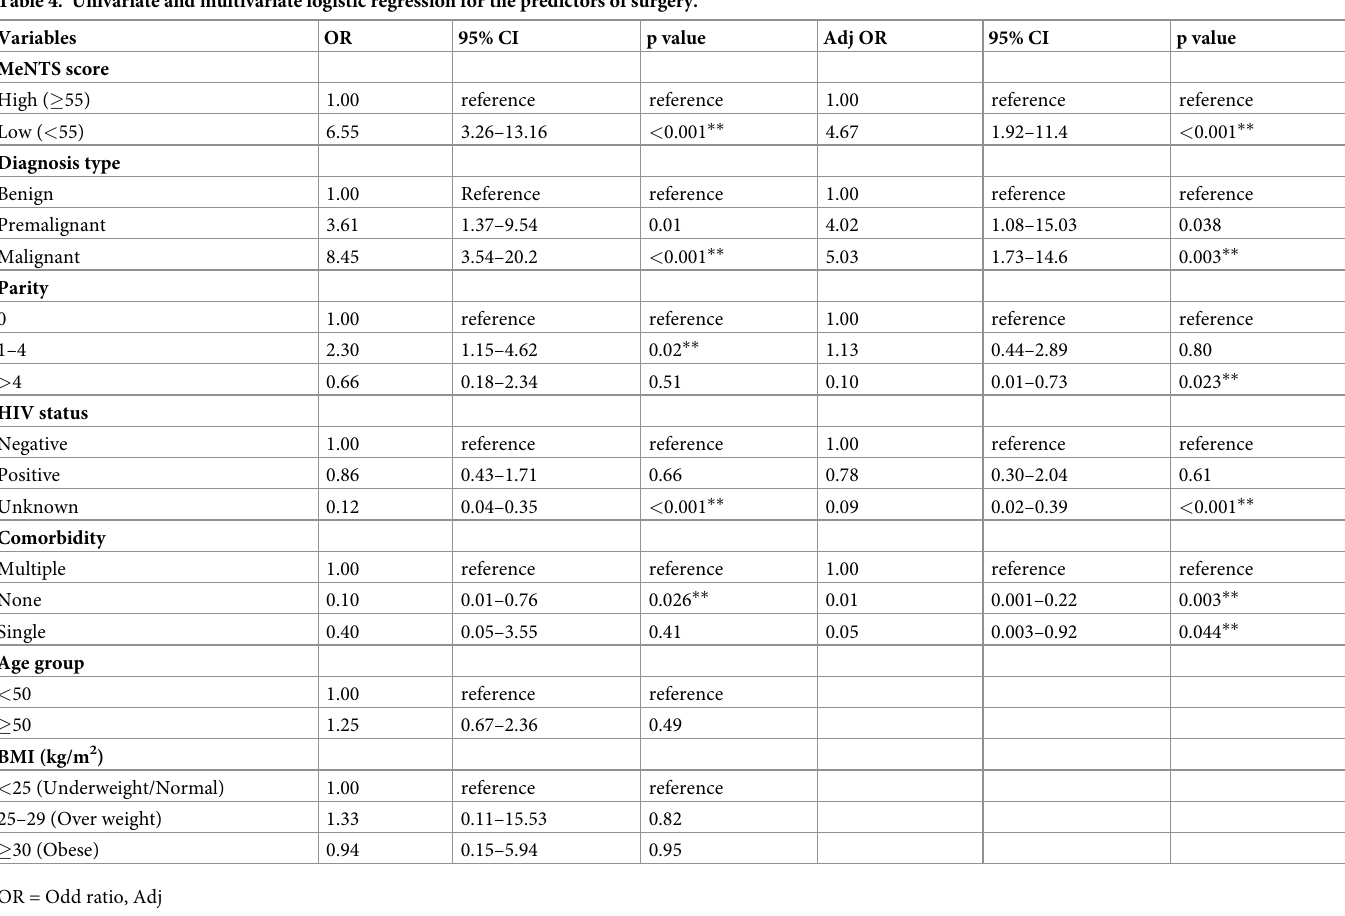
Table 4. Univariate and multivariate logistic regression for the predictors of